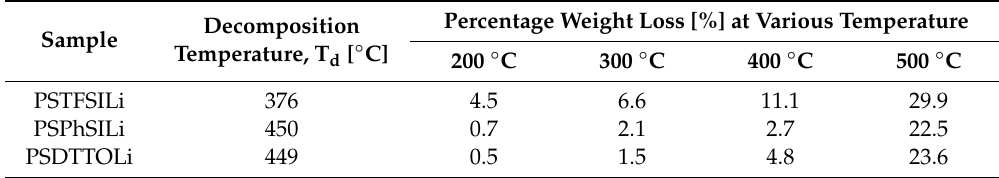
Figure 8. Thermogravimetric analysis (TGA) curves under air flow for PSTFSILi, PSPhSILi, and PSDTTOLi. Table 5. Thermal degradation of the PSLSs at different temperatures.